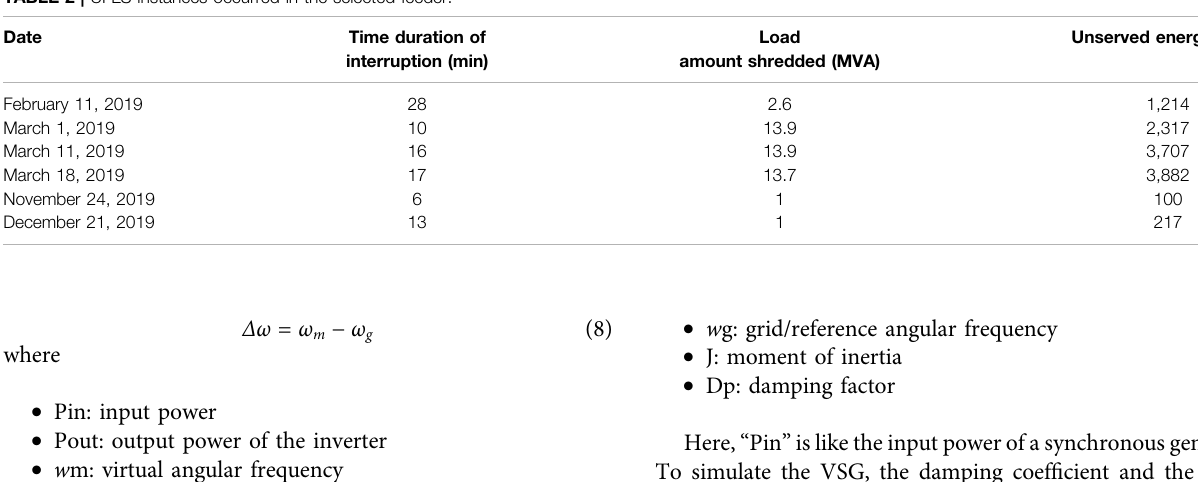
To simulate the VSG, the damping coef fi cient and the inertia